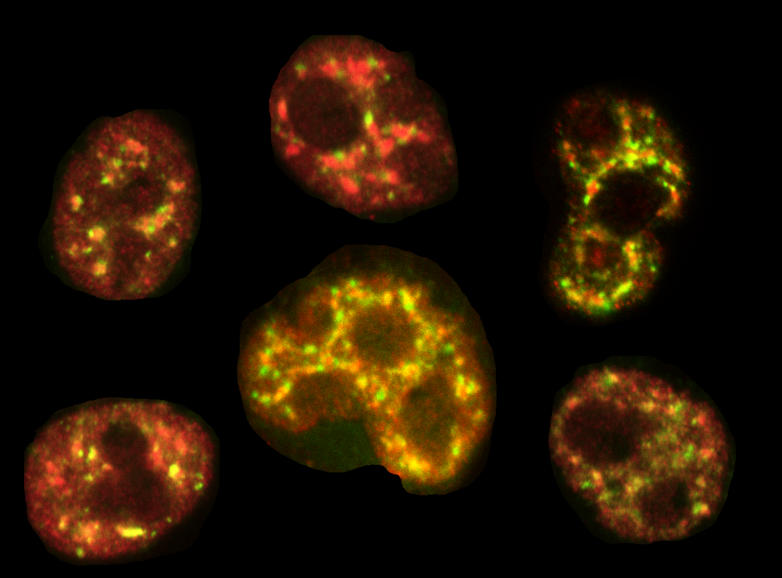
Pre-mRNA splicing factors (red) are recruited to sites of transcription and splicing (green) in the nucleus of mammalian cells